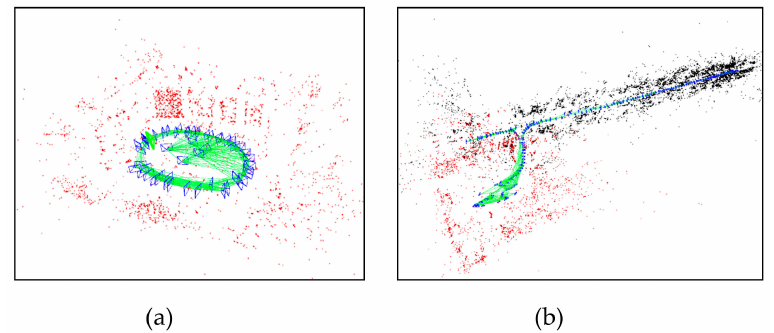
Figure 6. Examples of reconstructed map of the omnidirectional ORB-SLAM. Red points are active points, black points are old points, and blue rectangles are keyframes. Dataset: ( a ) room2; ( b ) corridor4.